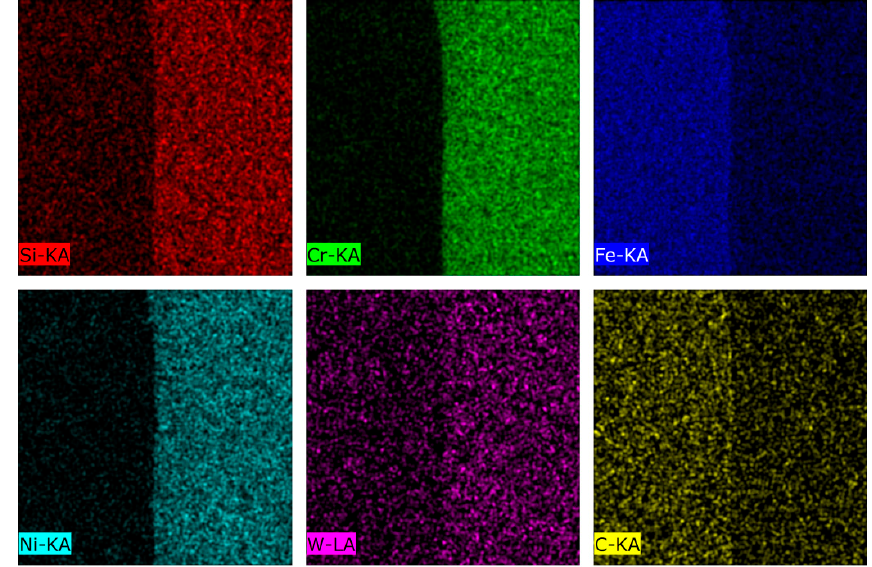
Figure 10. Plane scan analysis results at 200 mm/s.